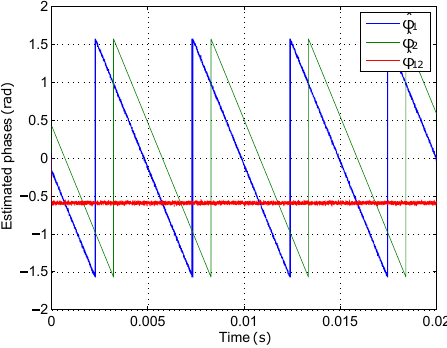
Figure 7. Output of phasemetters ( ˆ φ 1 , ˆ φ 2 , ˆ φ 12